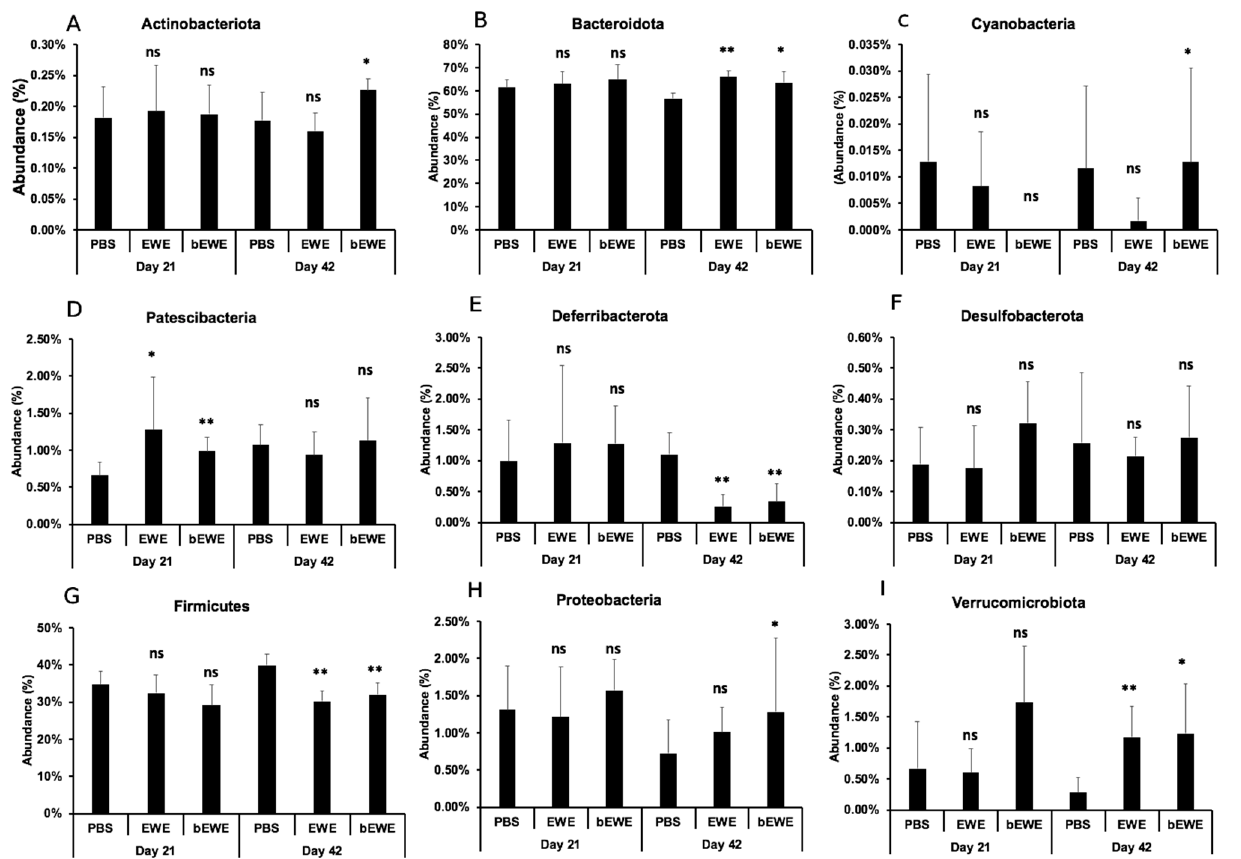
Figure 3. Relative abundance of bacterial taxa at the phylum level in mice treated with Euglena water extracts at Day 21 (before LLC cell inoculation) and Day 42 (after LLC cell inoculation). Percentage of taxa abundance of ( A ) Actinobacteriota, ( B ) Bacteroidota, ( C ) Cyanobacteria, ( D ) Patescibacteria, ( E ) Deferribacterota, ( F ) Desulfobacterota, ( G ) Firmicutes, ( H ) Proteobacteria, and ( I ) Verrucomi- crobiota is presented. The difference in taxa abundance for each phylum between PBS and EWE or bEWE was compared at Day 21 and Day 42 using a t -test. Results are presented as mean ± SD ( n = 5–6). *: p < 0.05; **: p < 0.01; ns: p > 0.05.